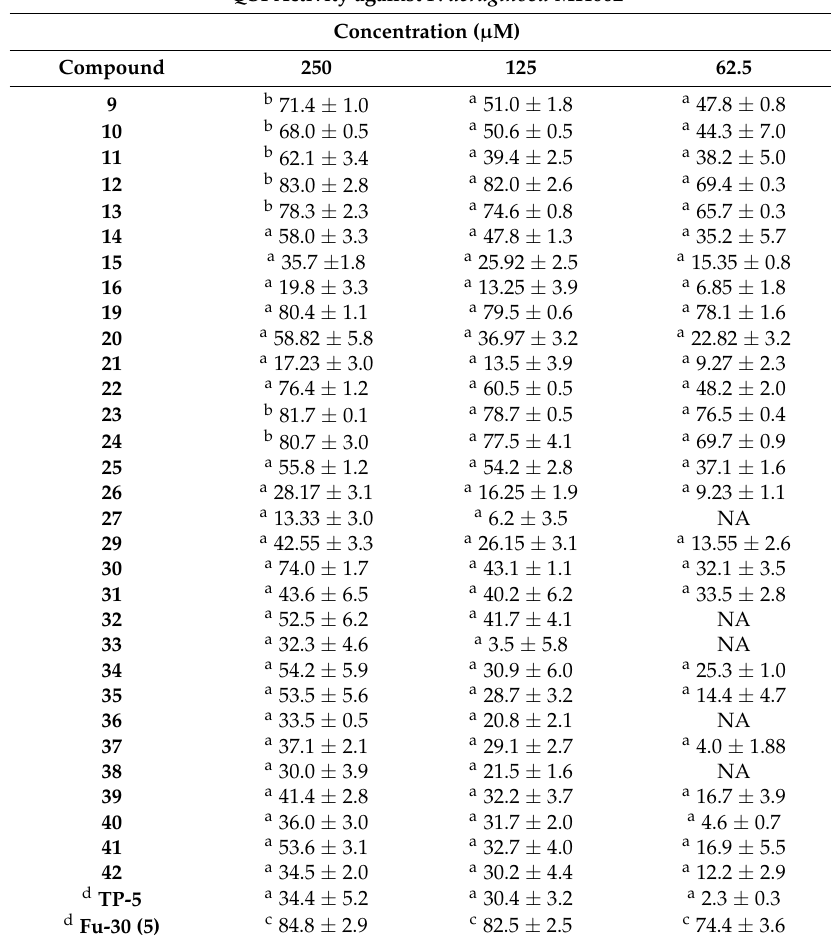
Table 1. Percentage inhibition of GFP fluorescence and the reduction of OD by the synthesized lactams against P. aeruginosa